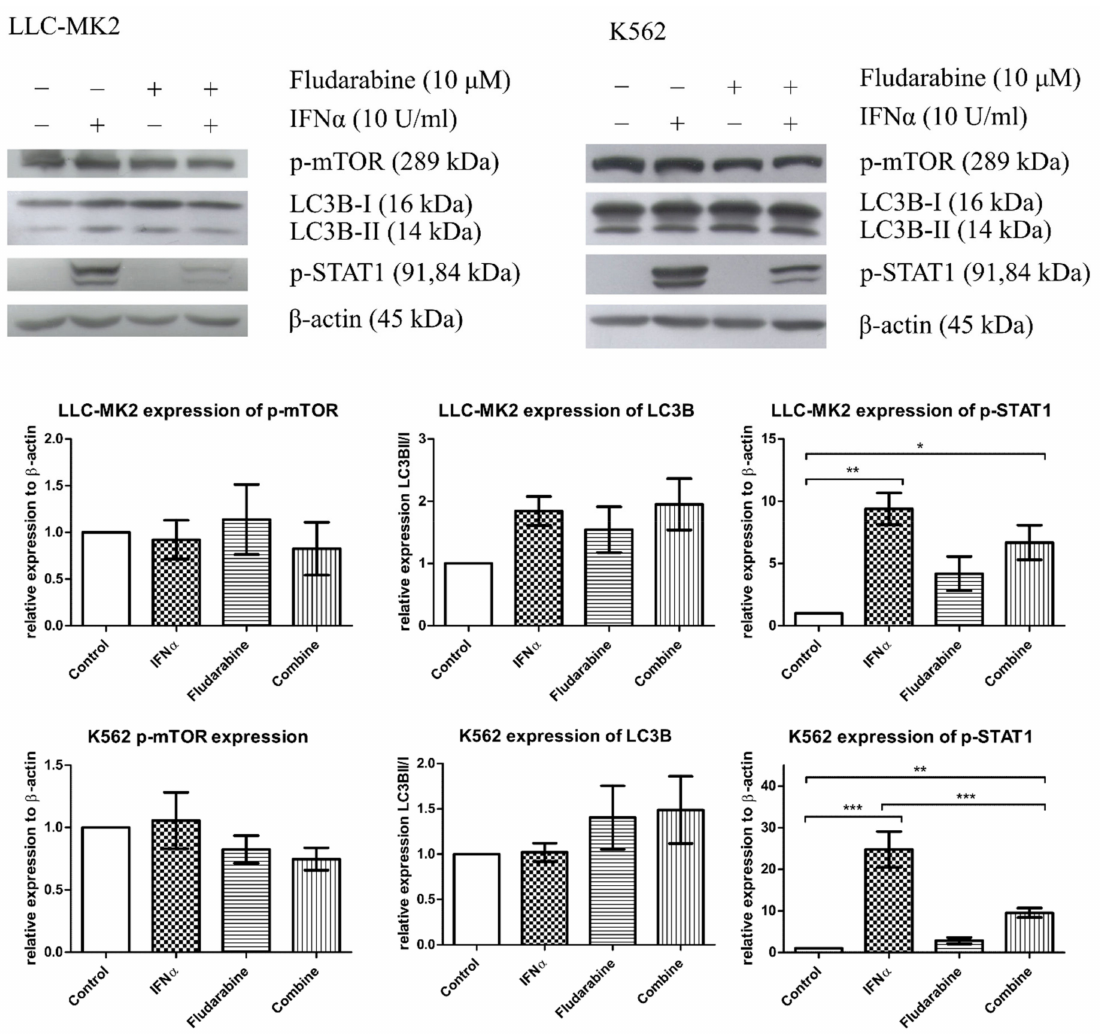
Figure 5. Western blot analysis of autophagy response and the antiviral response in cultured LLC- MK2 and K562 cells that were exposed for 60 min to IFN- α (10 U/mL) before treatment with Fdb (10 µ M) for 24 h. The cells were evaluated for autophagy response mediation via p-mTOR and LC3B-I/LC3B-II activation, as well as antiviral response via p-STAT1 signaling molecules. The total proteins were extracted and transferred to nitrocellulose membranes. The membranes were immunostained with p-mTOR, LC3B-I/LC3B-II, and p-STAT1 antibodies and processed for reaction color development. β -Actin was used as an internal control. Protein electrophoresis films were digitized and the relative density level of p-mTOR (normalized with β -Actin), autophagosome marker LC3B-II (normalized with LC3B-I), and p-STAT1 (normalized with β -Actin) were measured by using ImageJ ® software. One-way ANOVA statistical analysis was performed (*, **, *** indicates a p -value of <0.05, 0.01, 0.001, respectively). The experiments were analyzed in triplicate and SEM is marked by an error